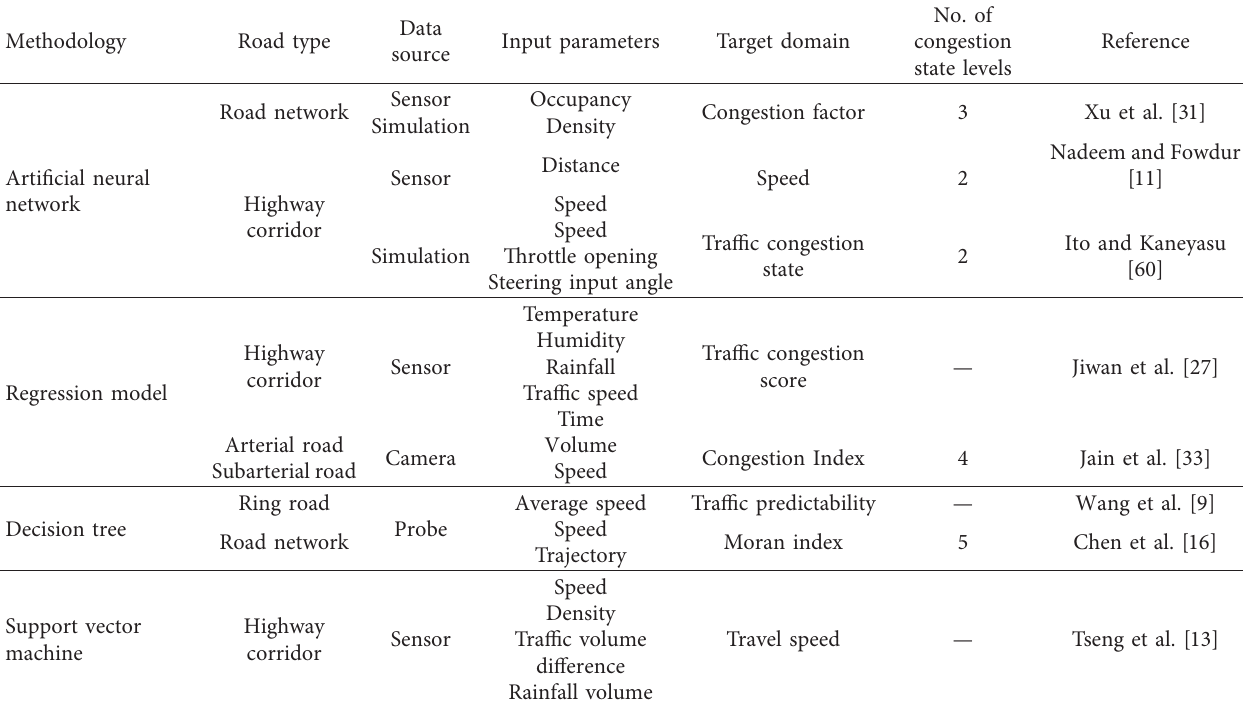
Table 2: Traffic congestion prediction studies in shallow machine